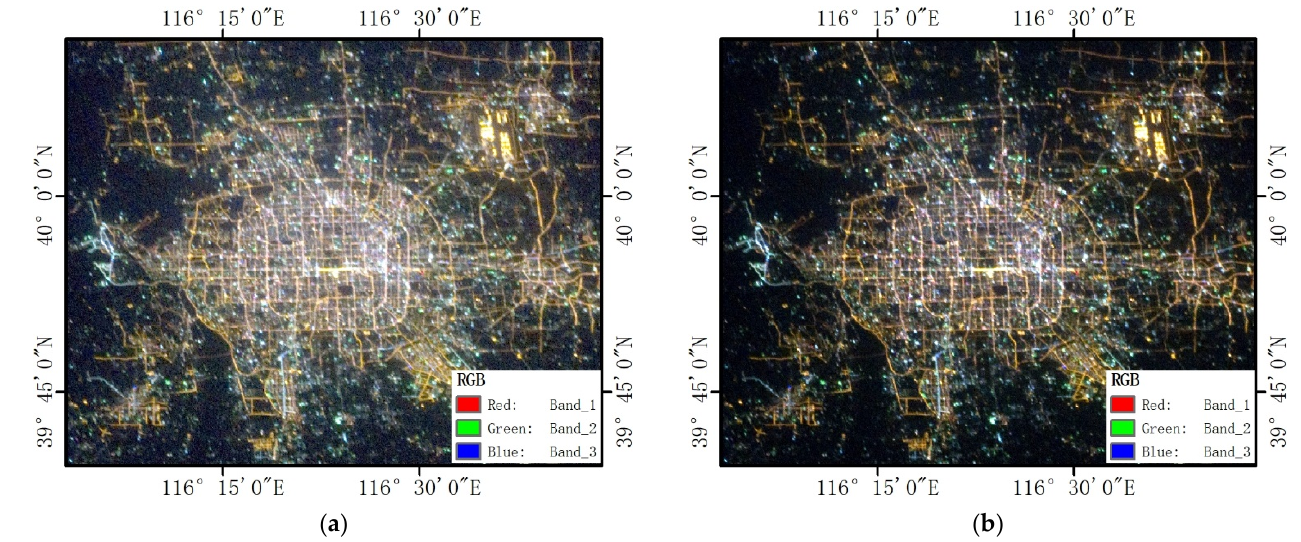
Figure 2. Before ( a ) and after ( b ) relative radiation normalization of International Space Station multi-spectral nighttime light image in Beijing area.